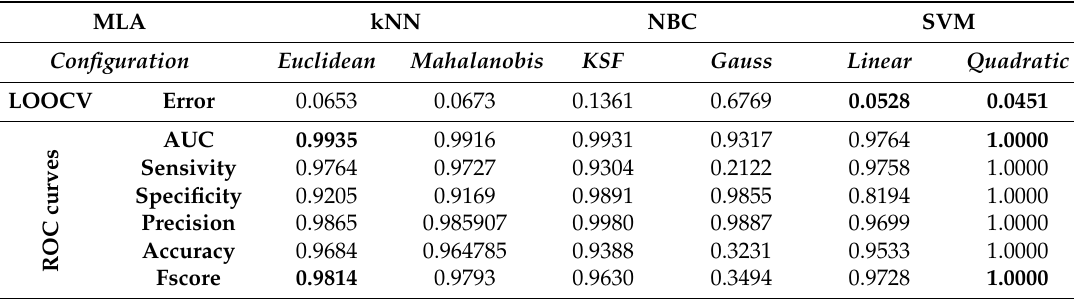
Table 3. LOOCV error and AUC for kNN, NBC, SVM.